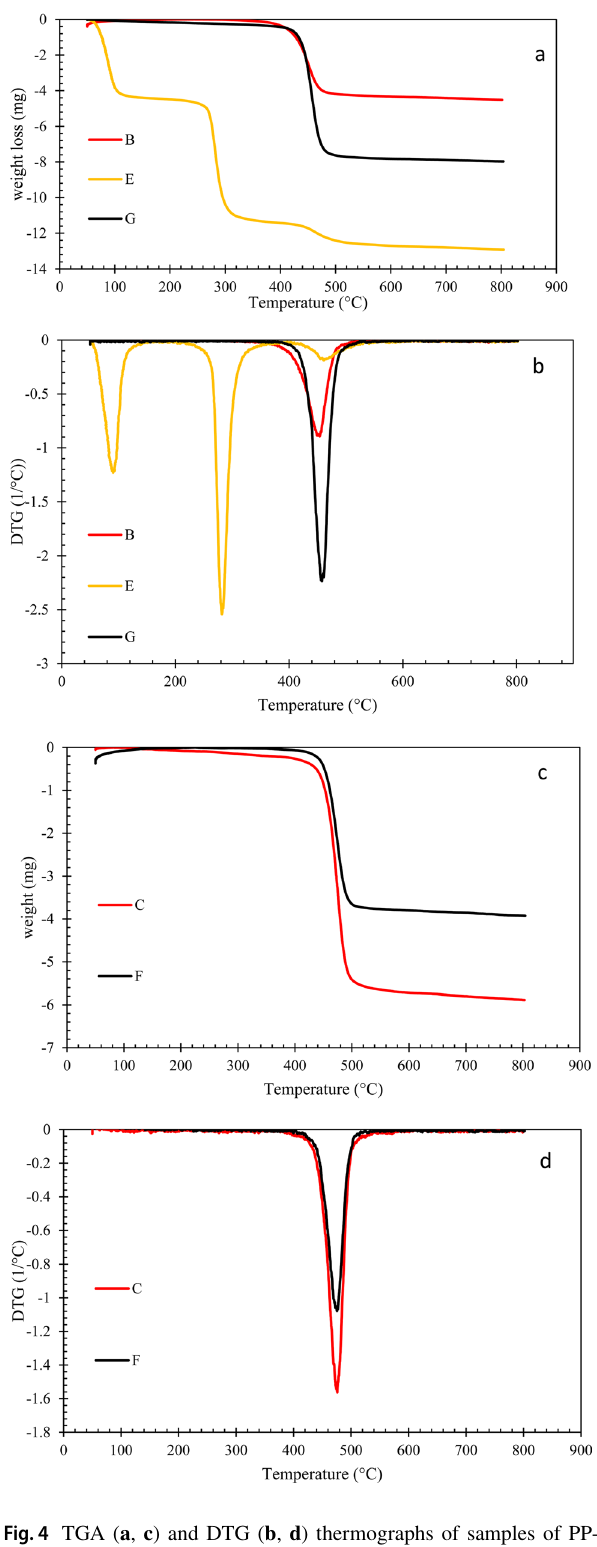
Fig. 4 TGA ( a , c ) and DTG ( b , d ) thermographs of samples of PP- based ( a , b ) and PE-based ( c , d